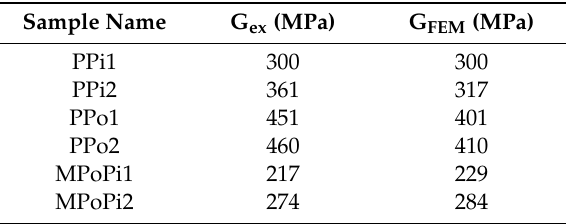
Table 6. Comparison of the shear moduli of elasticity. G ex : experimental shear modulus. G FEM : calibrated shear modulus used for numerical simulation.